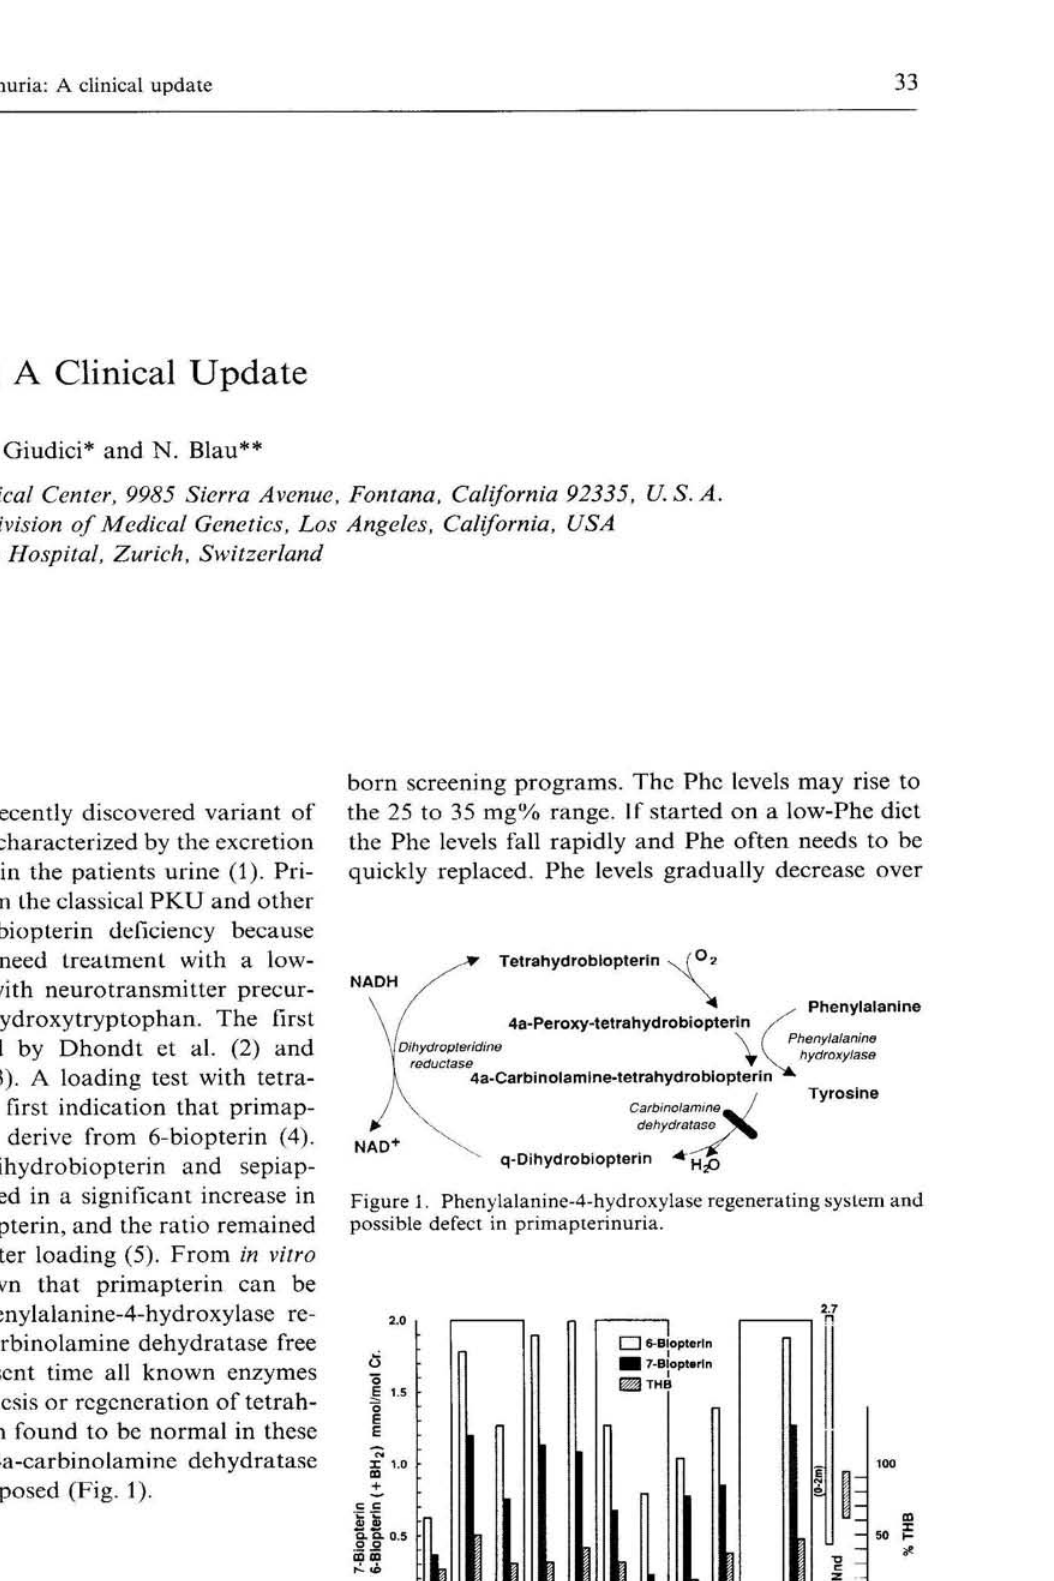
Figure 2. 6-Biopterin, 7-biopterin (primapterin) and tetrahy- drobiopterin (THB) in two children with primapterinuria at different ages. %THB of the sum of all biopterins. N. B. =